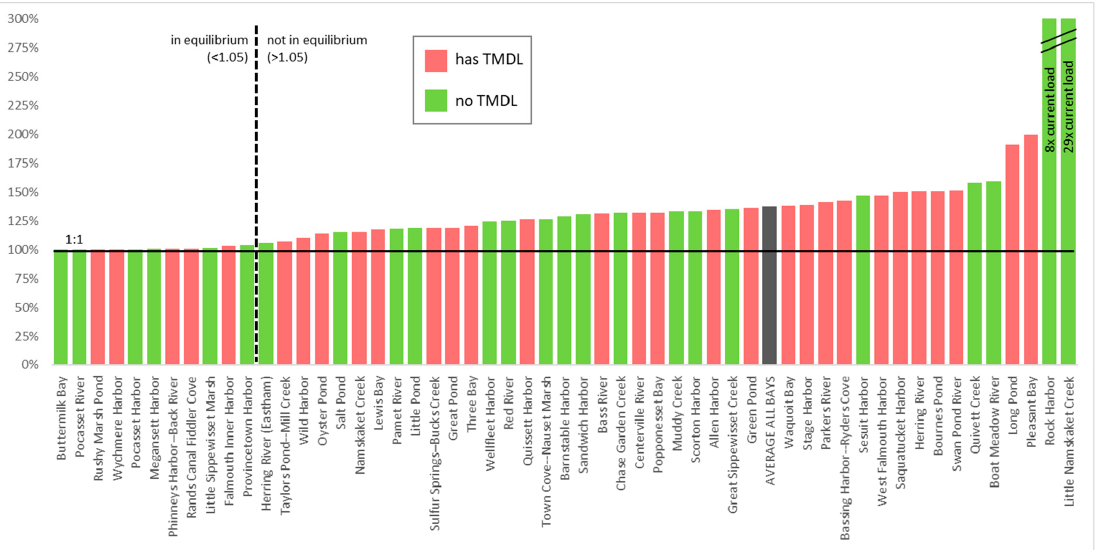
Figure 4. N loading in embayments on Cape Cod. Ratio of maximum future load (estimated) to current load. Bays at or near 1.0 are in equilibrium in terms of watershed load, while bays that exceed 1 are expected to experience greater N loading than current conditions. Rock Harbor (8 × current load) and Little Namskatet Creek (29 × current load) exceeded the scale of the y -axis of the